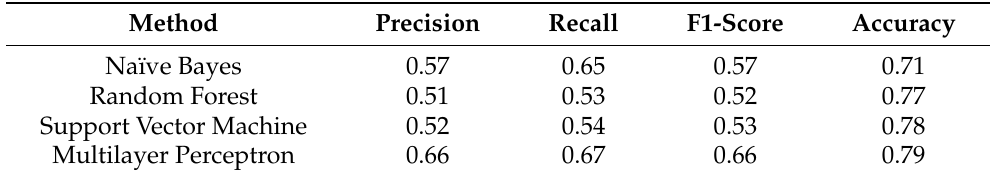
Table 1. Evaluations with Cro-CoV-cseBERT embeddings in terms of precision, recall, and F1-score calculated as macro averages (the complete results are in Appendix